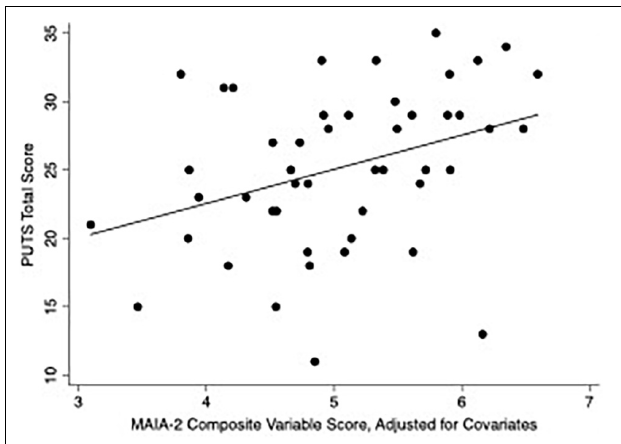
FIGURE 2 | Scatterplot of PUTS score versus MAIA-2 composite variable score. The MAIA-2 composite variable score is the mean of the scores from the following six MAIA-2 subscales: Noticing, Attention Regulation, Emotional Awareness, Self-Regulation, Body Listening, and Trusting. for the above plot, the composite score was adjusted for MAIA-2 Not-Worrying score, MAIA-2 Not-Distracting score, DOCS score, and YGTSS Total Tic Score, by inserting CTD-group median values for these variables into the regression